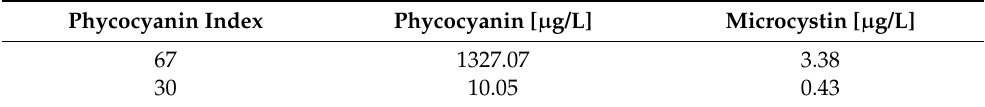
Table 2. Phycocyanin index derived from HICO image, correlated with phycocyanin in situ measure- ments, and correlated with microcystin concentration.